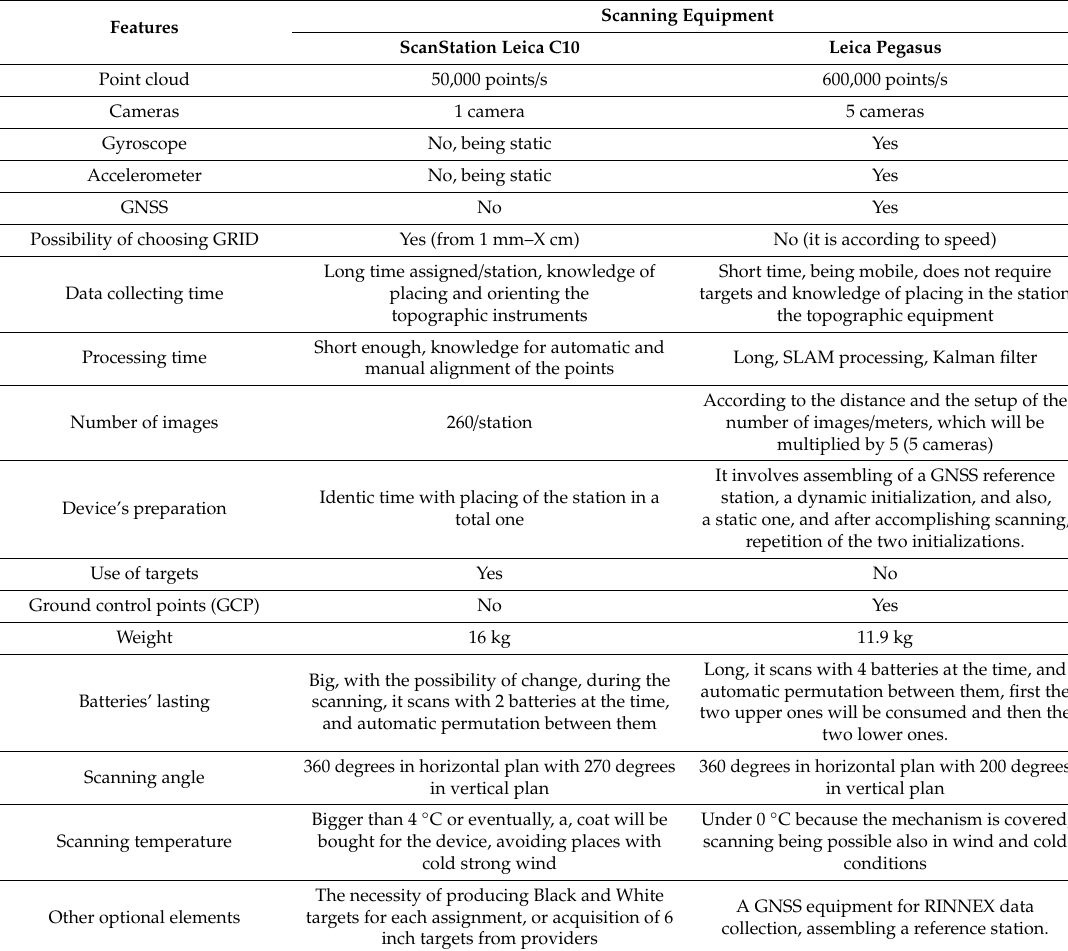
Table 1. Comparing scanning systems